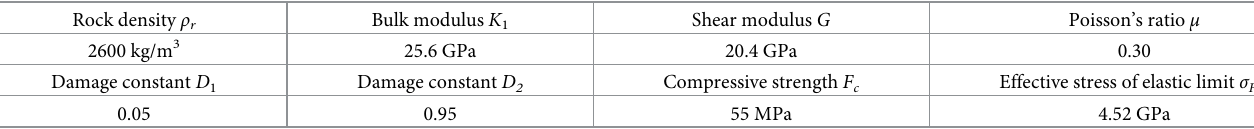
Table 2. The model parameters of rock damage simulation.